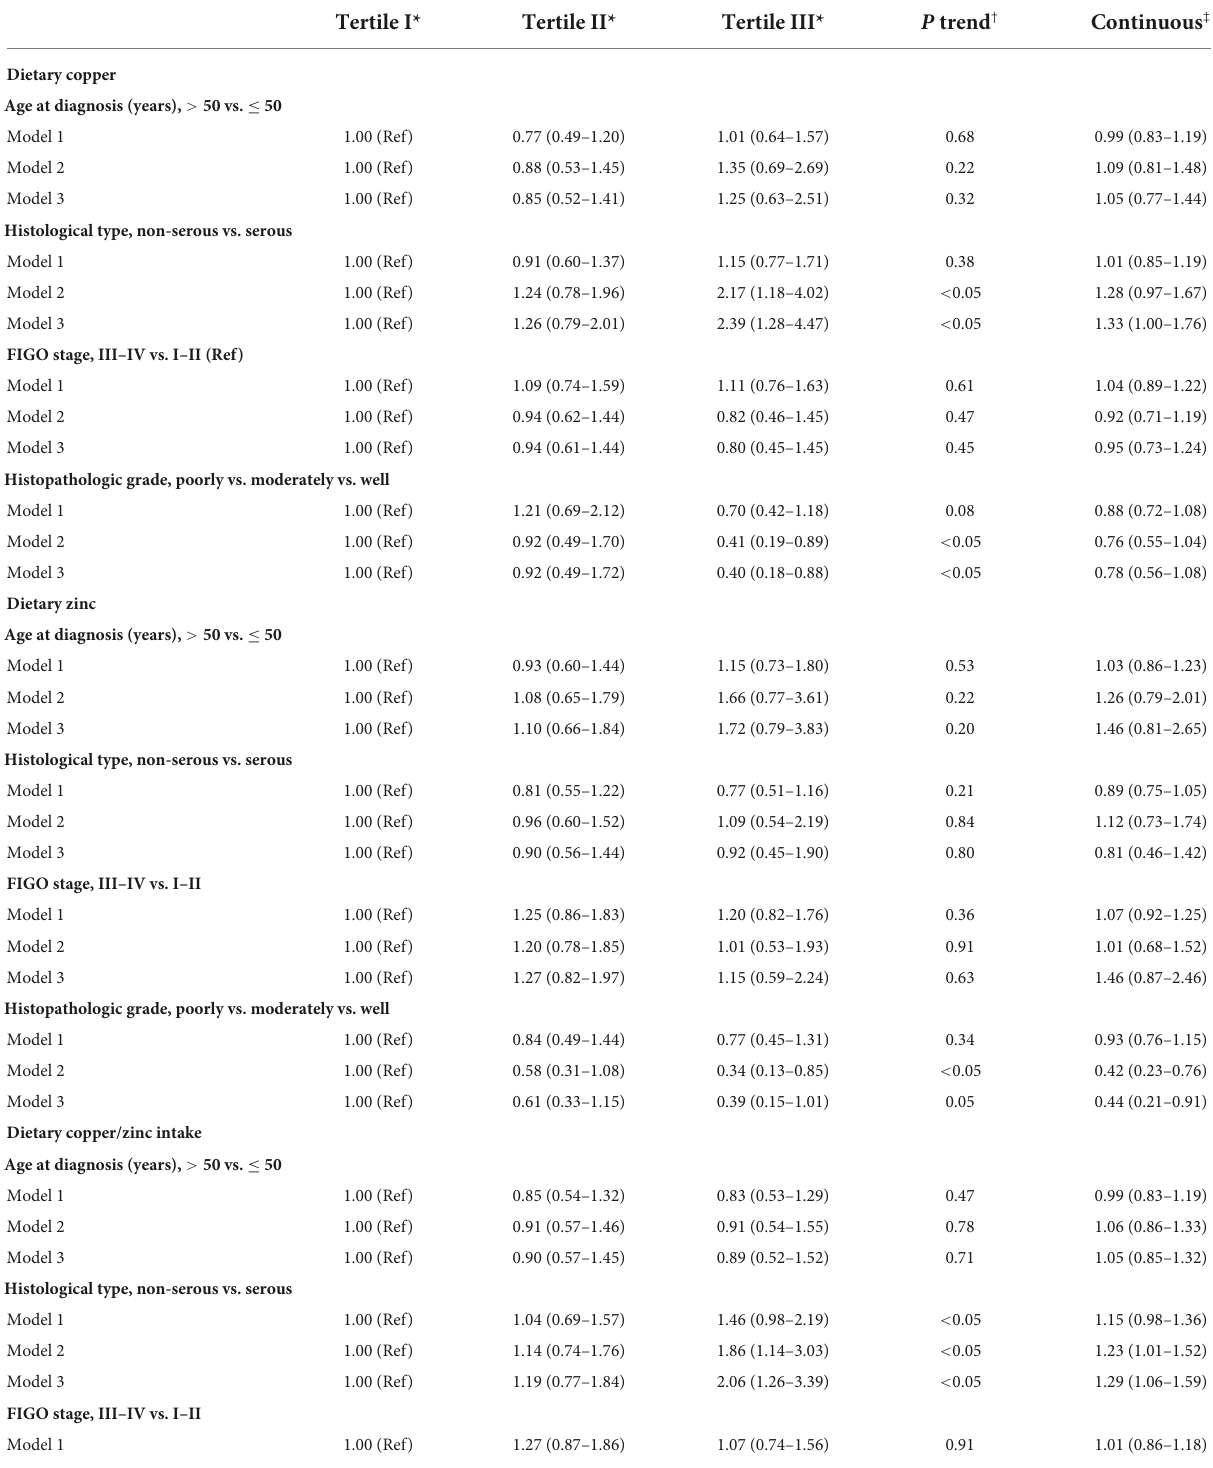
TABLE 3 Odds ratios (ORs) and 95% confidence intervals (CIs) for the association between dietary copper, zinc, and copper/zinc ratio intake and selected clinical characteristics among 701 ovarian cancer patients.